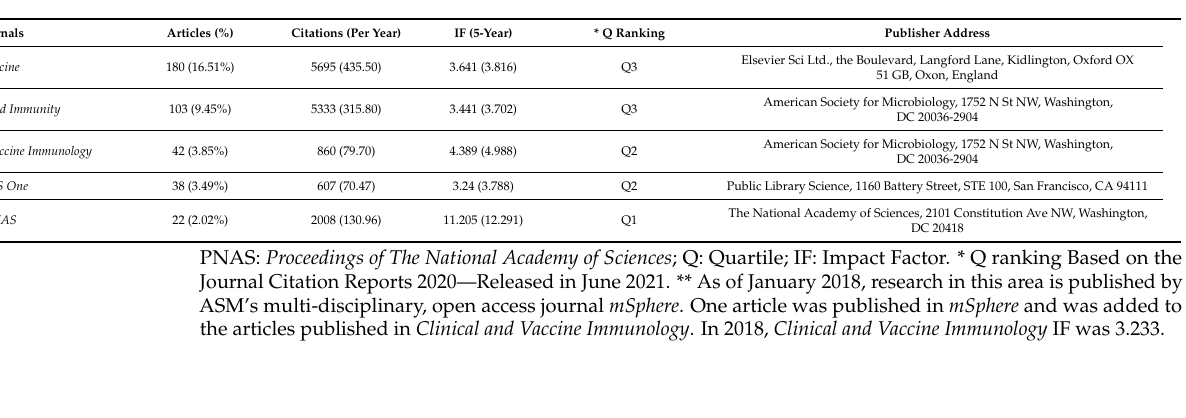
Table 4. Details of journals that published at least 15 anthrax vaccine-related